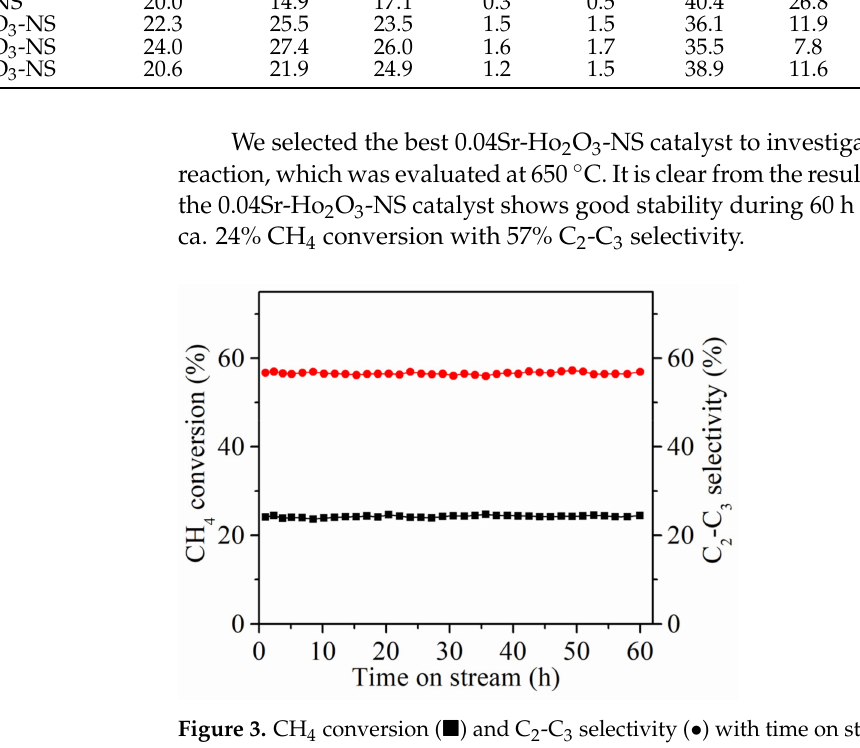
Figure 3. CH 4 conversion ( (cid:4) ) and C 2 -C 3 selectivity ( • ) with time on stream over 0.04Sr-Ho 2 O 3 -NS at 650 ◦